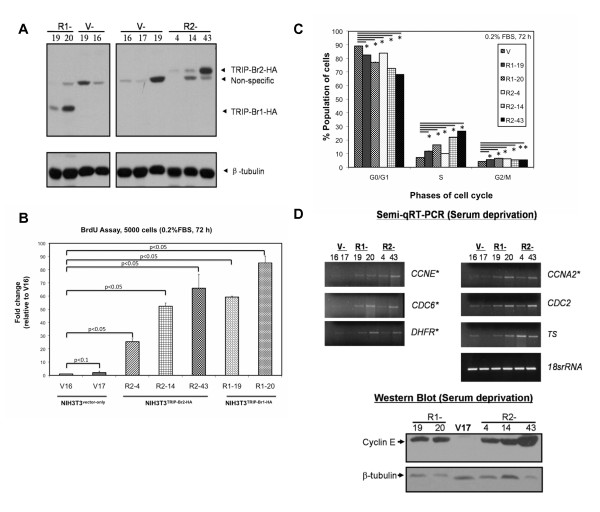
TRIP-Br-overexpressing-NIH3T3 fibroblasts proliferate in the absence of mitogenic stimulation as a result of deregulation of the RB/E2F/DP1 transcriptional pathway. V: Vector-only clones, R1: TRIP-Br1-HA-overexpressing clones, R2: TRIP-Br2-HA-overexpressing clones. β-tubulin was used as a loading control. (A) NIH3T3 fibroblasts were transfected with pCDNA3.1 vector (NIH3T3vector-only), pCDNA3.1-TRIP-Br1-HA (NIH3T3TRIP-Br1-HA) or pCDNA3.1-TRIP-Br2-HA (NIH3T3TRIP-Br2-HA), selected by G418, and analyzed by immunoblotting using an anti-HA antibody. Data was obtained from three independent experiments that were performed in triplicates. (B) NIH3T3vector-only, NIH3T3TRIP-Br1-HA and NIH3T3TRIP-Br2-HA fibroblasts were cultured in 96-well plates in DMEM supplemented with 0.2% FBS and were maintained for 72 h at 37°C in a 5% CO2 environment. BrdU incorporation was monitored using a cell proliferation/colorimetric ELISA assay. The fold increase in BrdU incorporation of all clones was calculated relative to that of V16, which was set arbitrarily to 1.0. The error bars represent the standard deviations of three independent experiments performed in triplicates. A Student's t-test was performed and the respective p-values were indicated in the bar chart. (C) Upon serum deprivation, S phase cell counts were significantly higher in the TRIP-Br-overexpressing NIH3T3 clones than the vector-only control. The results shown represent the mean ± SD for each independent R1 (-19 and -20) and R2 clone (-4, 14, 43), compared to all V clones combined (-16, -17, -19), and incorporate data from 3 independent experiments performed in triplicate. A Student's t-test was performed; *indicates p-value < 0.001; **indicates p-value < 0.01 for the comparison of NIH3T3vector-only and NIH3T3TRIP-Br1-HA or NIH3T3TRIP-Br2-HA cells. (D) Upper panel: Semi-quantitative RT-PCR analyses revealed up-regulation of CYCLIN E (CCNE), CYCLIN A2 (CCNA2), CDC6 and DHFR in serum-deprived NIH3T3TRIP-Br1-HA and NIH3T3TRIP-Br2-HA fibroblasts. TS: Thymidylate synthase; 18srRNA was used as a loading control. Data was obtained from three independent experiments that were performed in triplicates. Lower panel: Western blot analyses showed an increase in cyclin E in serum-deprived NIH3T3TRIP-Br1-HA and NIH3T3TRIP-Br2-HA fibroblasts when these cells were immunostained with anti-cyclin E antibodies. Data was obtained from three independent experiments that were performed in triplicates.